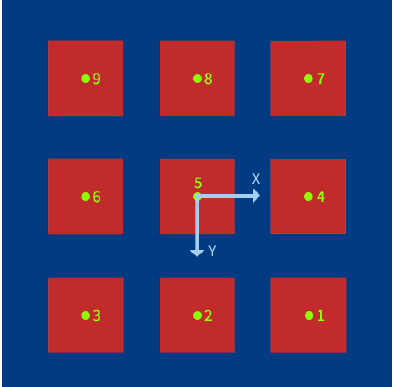
Figure 6. Backgroundsubtraction,regionofinterest(ROI)selectionandfootpositionmeasure. ( a )Background subtraction. ( b ) Feet selection.